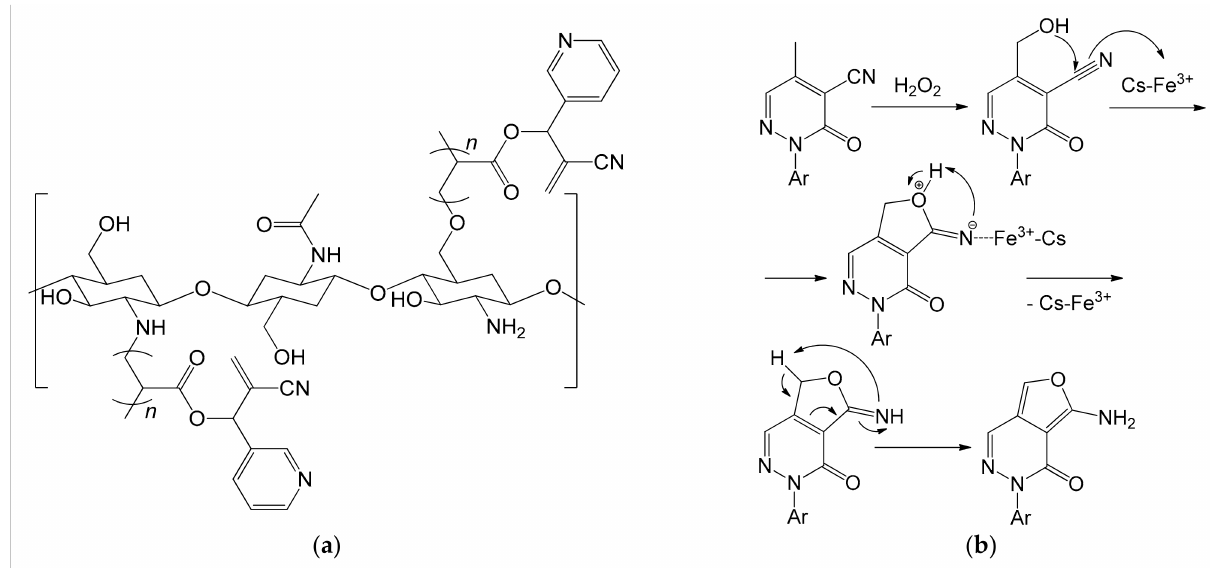
Figure 20. ( a ) Chitosan polymeric chain grafted with 2-cyano-1-(pyridin-3-yl)allyl acrylate (CPA); ( b ) Proposed mechanism of the oxidation reaction of methylpyridazone using grafted chitosan with immobilized Fe 3+ ions (Cs–Fe 3+ ) as catalyst (Ar = phenyl, 4-chlorophenyl)